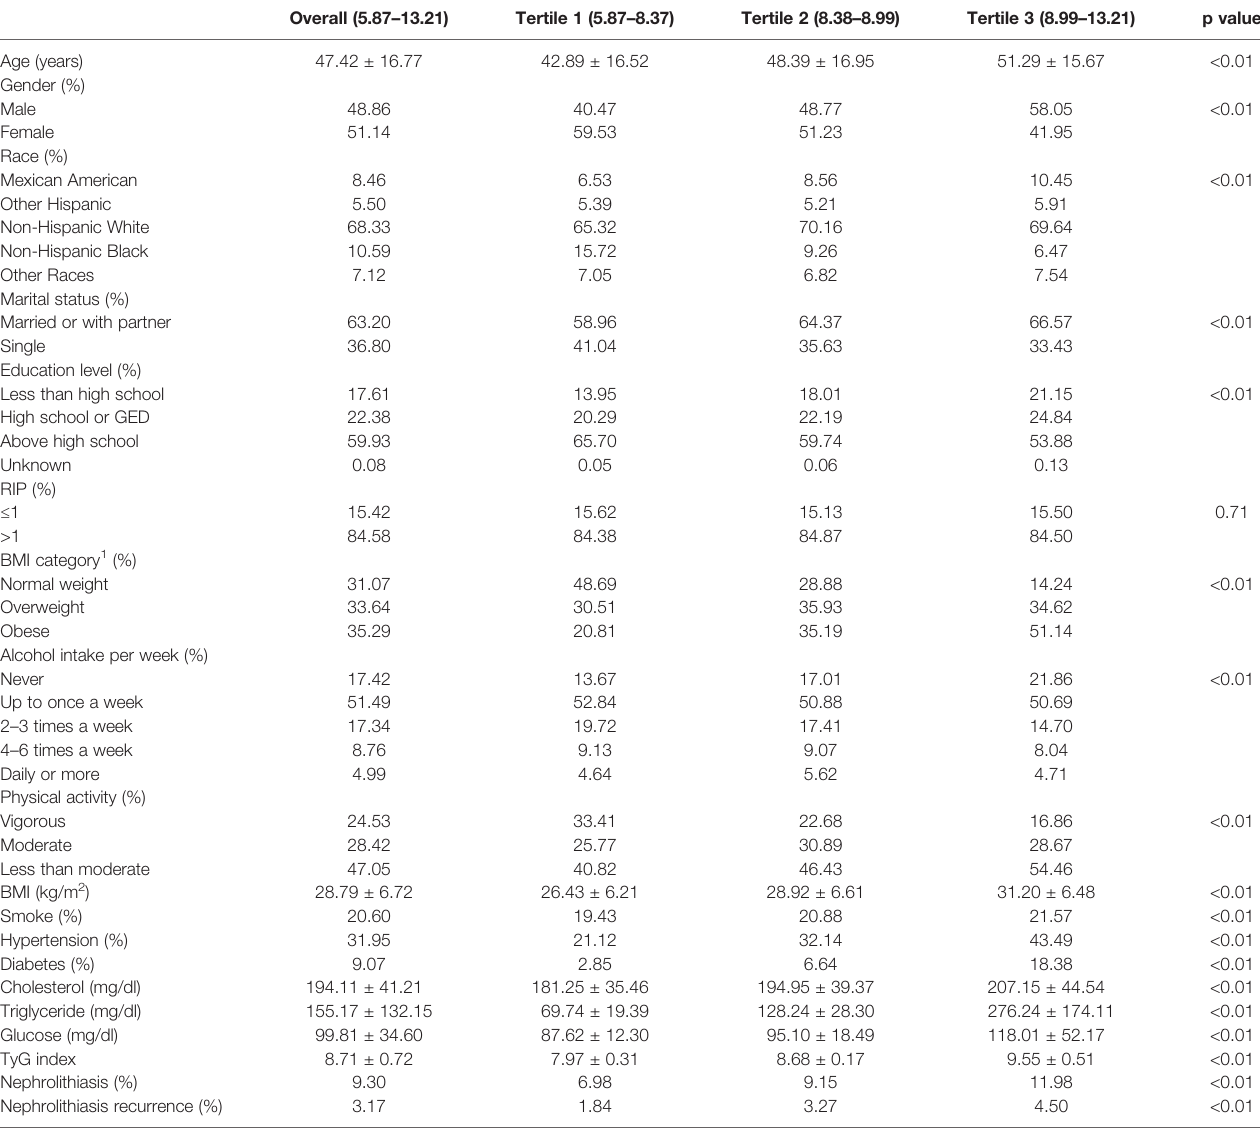
TABLE 1 | Baseline characteristics of participants,